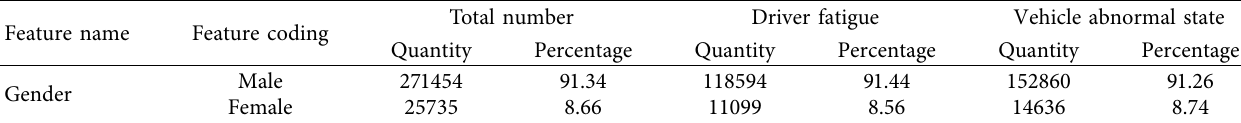
Figure 12: Distribution of forewarning types for drivers of different ages. Table 8: Distribution of forewarning types of buses for drivers of different